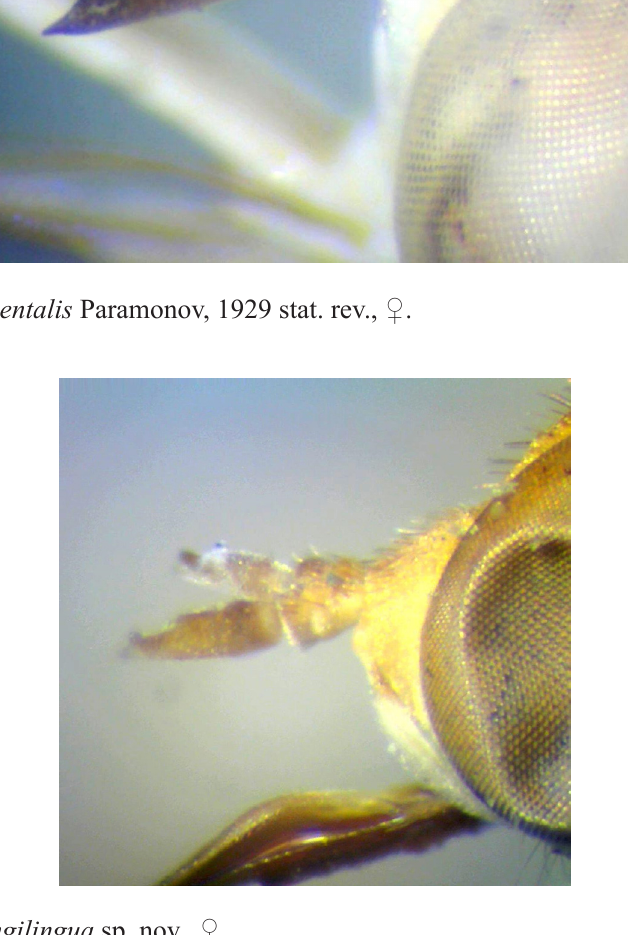
Fig. 28. Parageron longilingua sp. nov.,